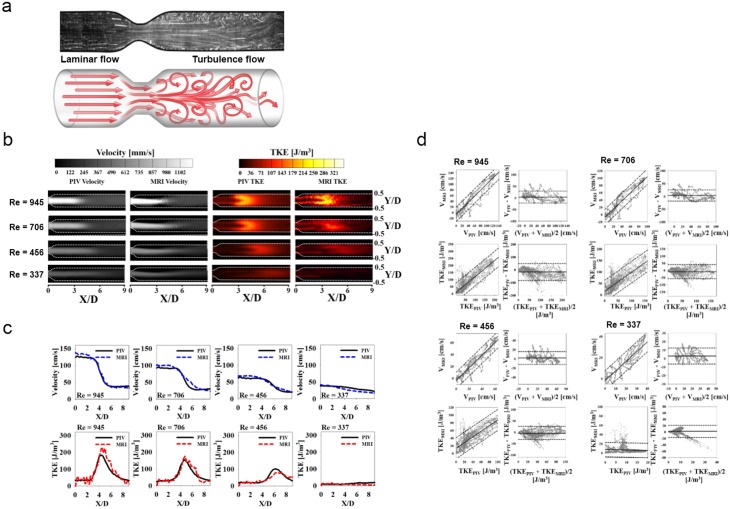
Comparison of 4D PC-MRI measurements using conventional PIV measurements.(a) Representative flow characteristics through a stenotic vessel. Flow visualization (upper panel) in PIV and schematic drawing (lower panel) indicate the development of a turbulent flow in the post-stenosis region. (b) Comparison of velocity and TKE distribution in the post-stenosis region. (c) Comparison of velocity (upper panel) and TKE (lower panel) along the centerline of the stenosis. (d) Linear regression and Bland–Altman analysis of velocity and TKE measured using PC-MRI and PIV at Re = 945, 706, 456, and 337. Note that solid and dotted lines in the linear regression indicate mean and 95% prediction band. Solid and dotted lines in the Bland–Altman plot indicate mean and 1.96 SDs.